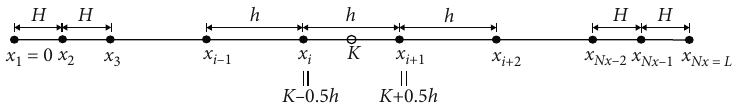
Figure 6: Mesh with a mesh size h for the convergence test. Table 1: Three-asset cash-or-nothing option prices with varying